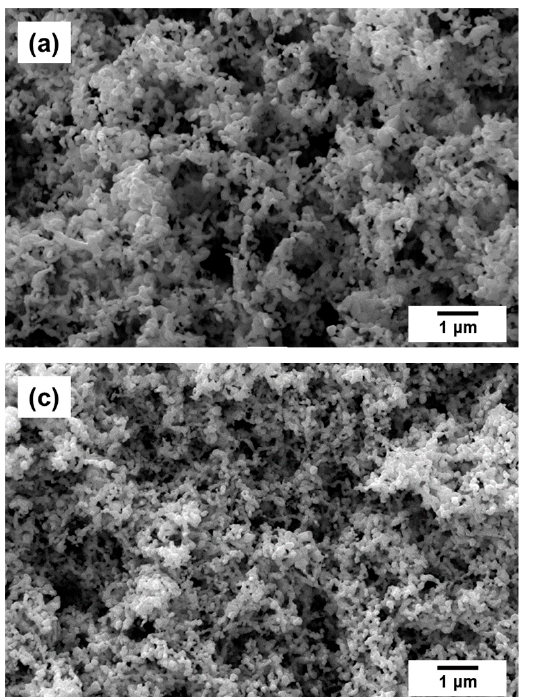
Table 1. Chemical composition and crystallographic characteristics of synthesized Pt 1 − x Ni x (x = 0.0–1.0) alloys.